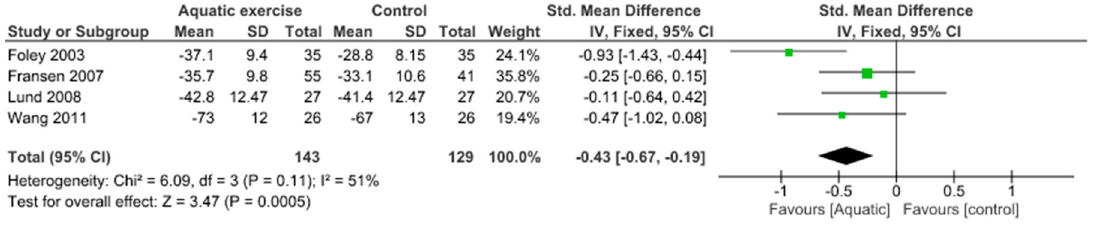
Figure 12. Quality of Life: Aquatic exercise versus Land-based exercise.